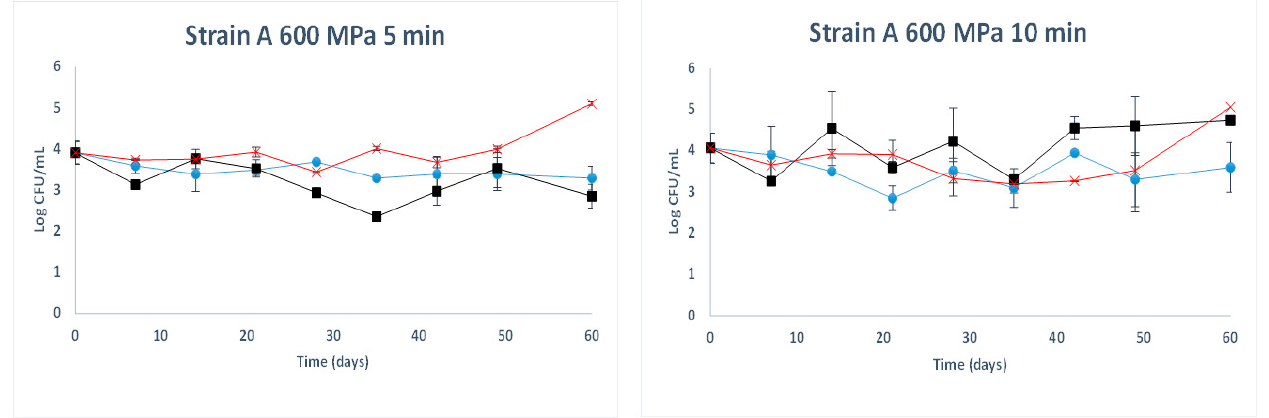
Figure 1. Survival curves of A. acidoterrestris (Strain A) spores treated at 600 MPa/60 °C for 5 and 10 min and stored at 4 °C ( ● ), 12 °C ( ■ ) and 25 °C (x). Data points are mean values ± standard deviation of duplicate samples from two independent experiments ( n = 4).